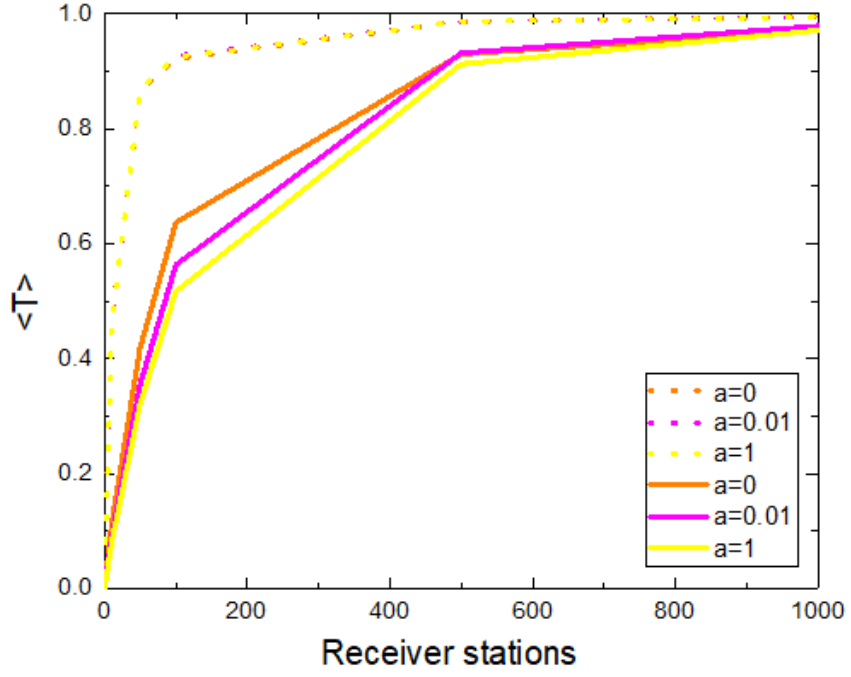
Figure 7. Average number of transmitted packages per unit of time and animal as a function of the number of receiver stations for the case of mobile receiver stations. The animals move with v = 0.001. We include the scenarios where the receiver stations move (i) with the same velocity (solid line) and (ii) with higher velocity (dotted line, v = 0.01). For each scenario, we include results for three different values of a . We show results averaged over 100 realizations, 20,000 time steps were considered and r =